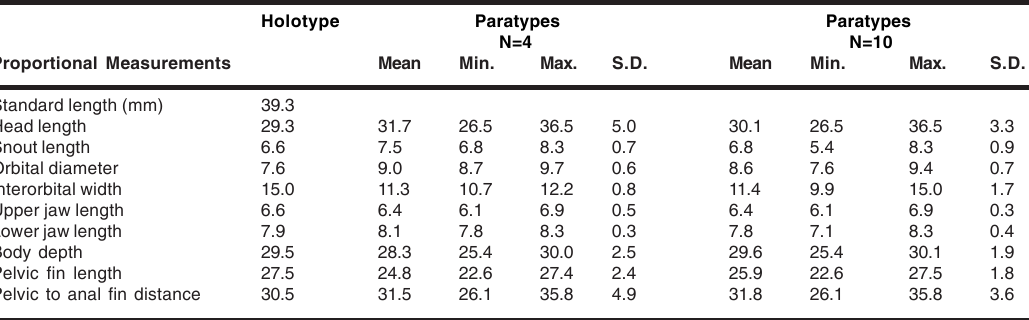
Table 1. Proportional measurements of Badis dibruensis sp. nov. in percentage of standard length except standard